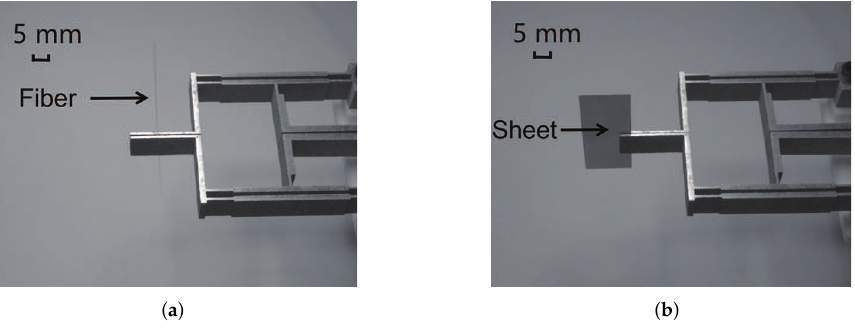
Figure 17. Snapshots of gripping experiments. ( a ) An optical fiber with a diameter of 200 µ m; ( b ) a sheet with a thickness of 100 µ